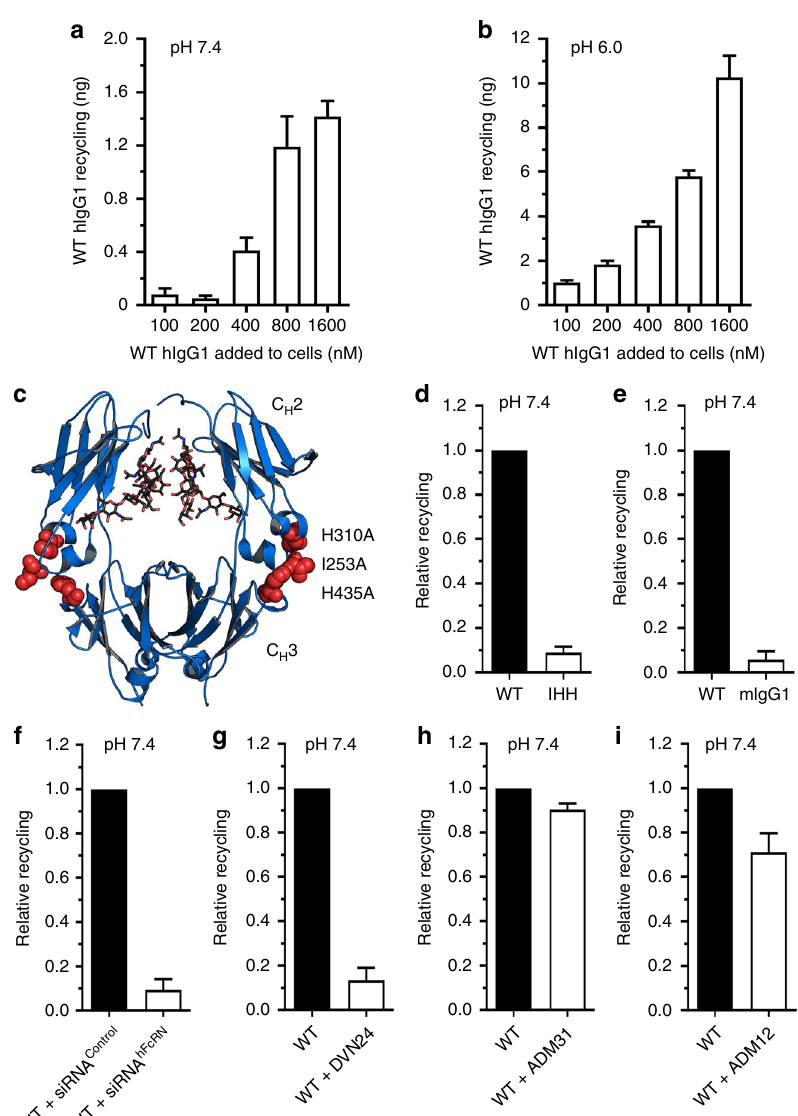
Fig. 2 Recycling of IgG is dependent on FcRn. Recycling of WT hIgG1 at a pH 7.4 and b pH 6.0 after 4 h incubation with titrated antibody concentrations (100 – 1600 nM). c An illustration of the hIgG1 Fc crystal structure where the mutated residues in hIgG1-IHH (I253A, H310A and H435A) are highlighted in red. The fi gure was designed by using the PyMOL software with the crystallographic data of hIgG1 Fc 69 . The amount (ng) recycled for each of the hIgG1 variants was used to calculate relative recycling compared with the WT that was set to 1.0. Histograms showing relative recycling of d WT and hIgG1-IHH, e WT hIgG1 and mIgG1, and f WT hIgG1 by HMEC1-FcRn cells transfected with control or hFcRn-speci fi c siRNAs. Relative recycling of WT hIgG1 in the presence of g DVN24 (binds the IgG binding site on hFcRn), h ADM31 (binds the HSA binding site on hFcRn) and i ADM12 (does not bind the ligand binding sites) are shown. Obtained data are given as mean ± s.d. of three independent experiments performed in